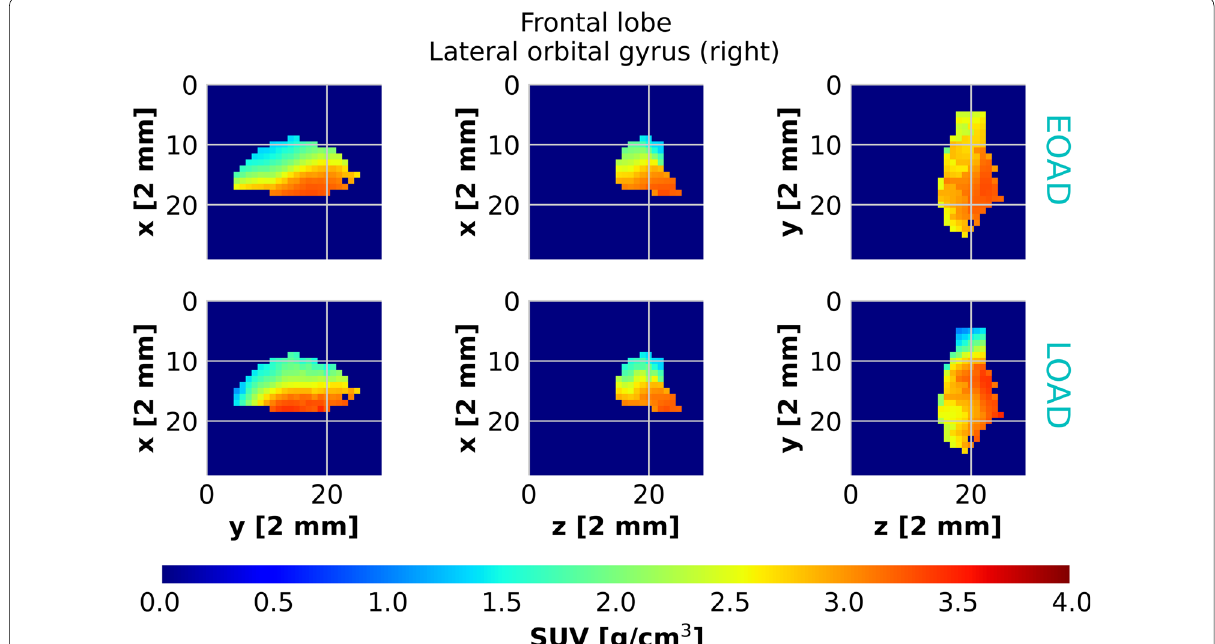
Fig. 2 A β plaques in the right lateral orbital gyrus of the frontal lobe, observed with [ 18 F]florbetaben PET. The right lateral orbital gyrus of the frontal lobe: maximal projection [ 18 F]florbetaben PET images of EOAD (upper row) and LOAD (lower row) patients. The SUV does not exhibit any significant difference between the two classes of